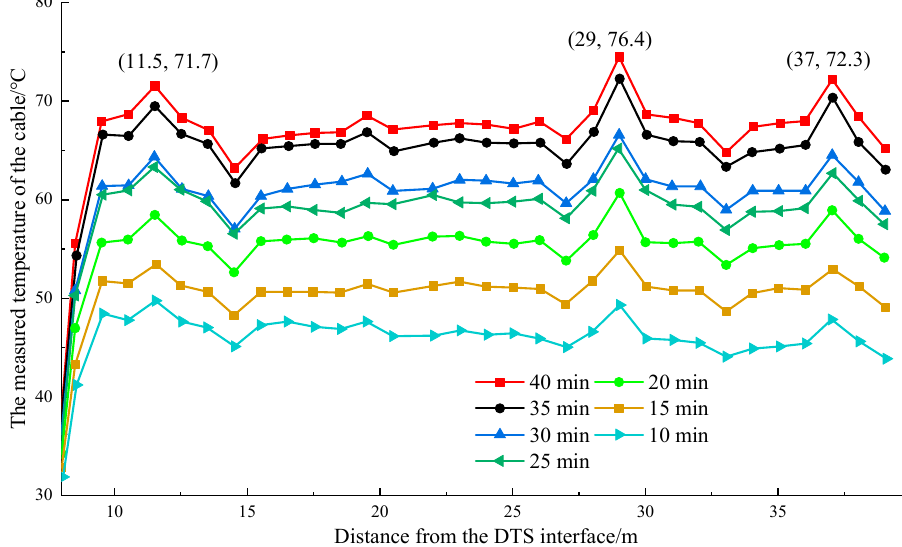
Figure 11. Temperature change curve of the pipeline.